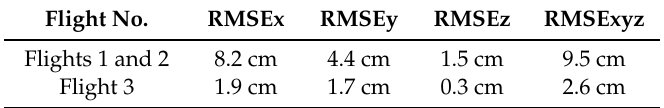
Table 2. The computed RMSE values for all three flights processed in Agisoft PhotoScan Professional. Flight